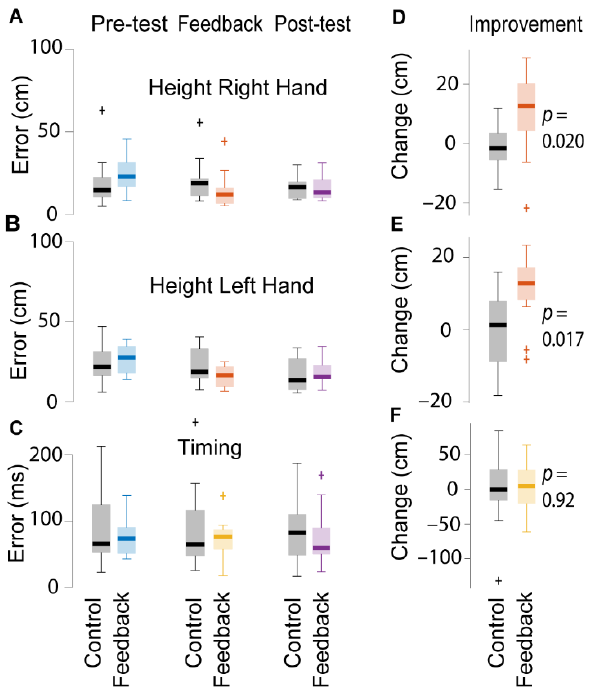
Figure 5. Effect of height and timing feedback. ( A – C ) displays the height/timing of the throws before feedback, at the end of the feedback sessions, and on the post-test. ( D – F ) displays how much the height/timing of the throws improved during the feedback session. This was calculated by taking the average error on the last 10 trials before the feedback session (throws 41–50) and subtracting the average error on the last 10 trials of the feedback session (41–50 for height; 91–100 for timing), and then comparing the change to the change in the control group. Participants receiving feedback on height improved the height of their throws more than those who did not receive feedback. However, this was not the case for the timing feedback.